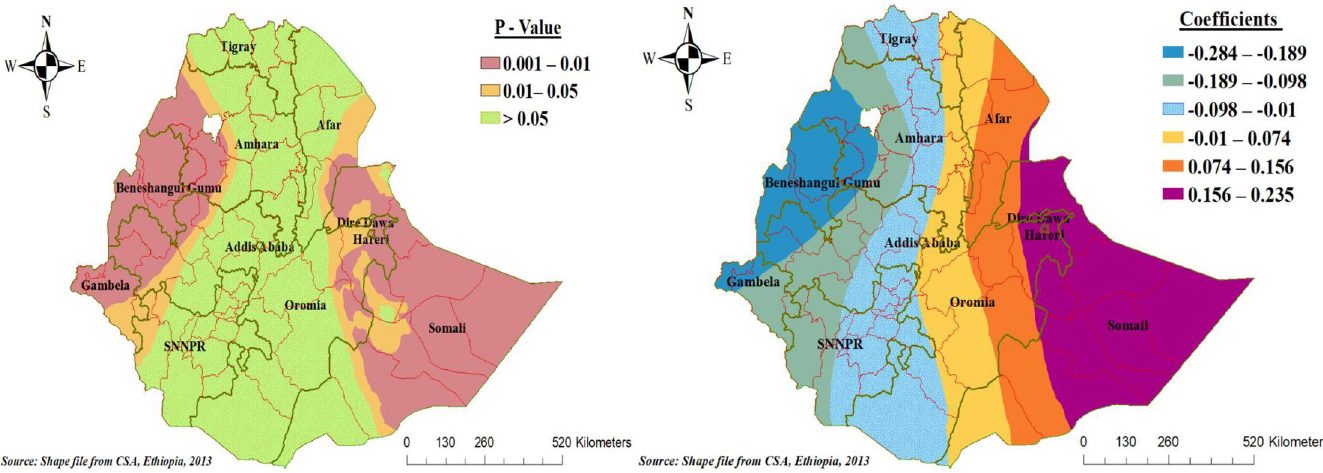
Fig 7. Geographically varying values of significance and coefficients per cluster for the independent variable living tropical area of poor consumption foods rich in vitamin A in the final GWR model.